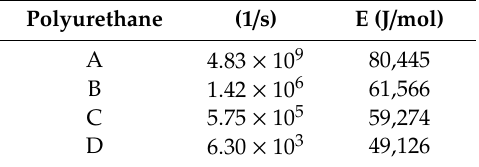
Table 2. Values of pre-exponential factor ∆ and activation energy E for the